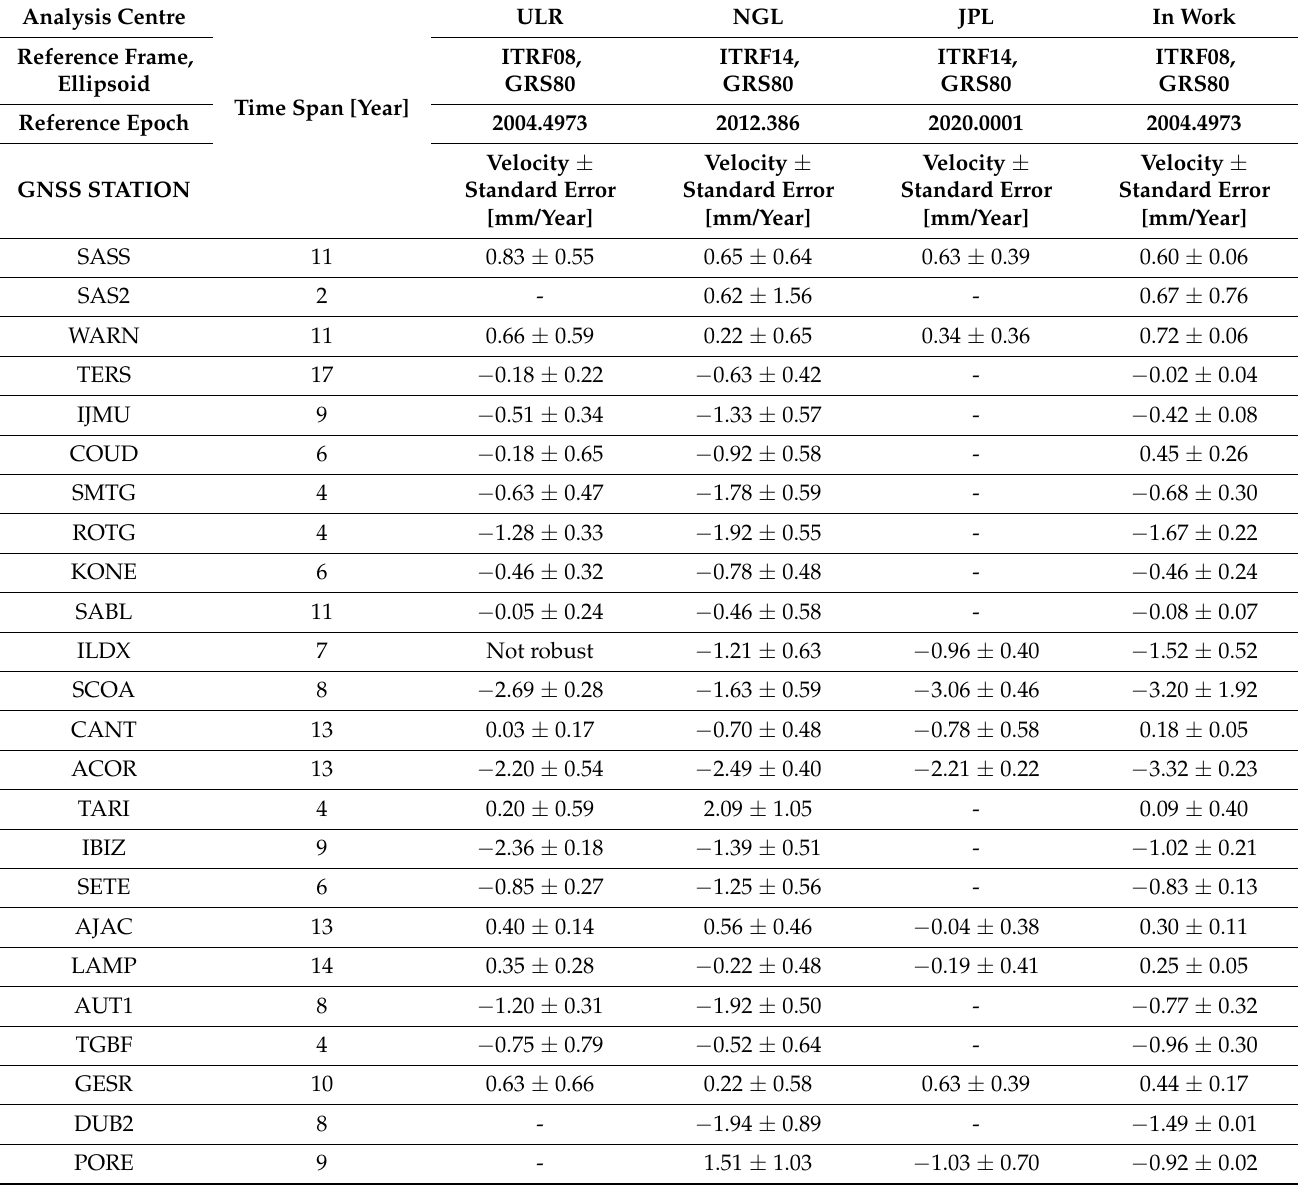
Table 1. Velocities of crust movement calculated in this study are based on GNSS data and SONEL network data calculated by three analytical centres (ULR, NGL,